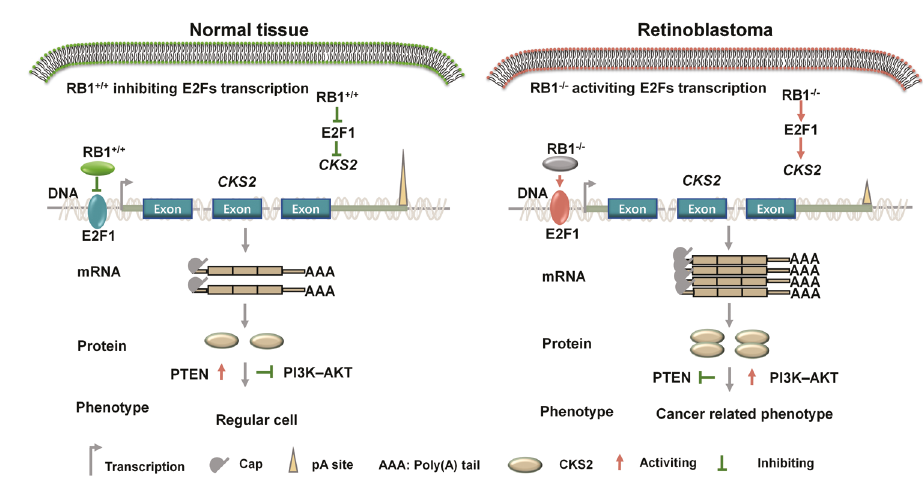
Fig. 6 Working model for E2F1/CKS2/PTEN signaling axis in regulating malignant phenotypes of RB. CKS2 exhibits aberrant higher expression in retinoblastoma compared with normal controls. Upregulated transcription factor E2F1 bound to upstream of CKS2 transcription start site and promoted CKS2 protein production, leading to cancer-associated phenotypes, possibly by regulating PI3K – AKT signaling